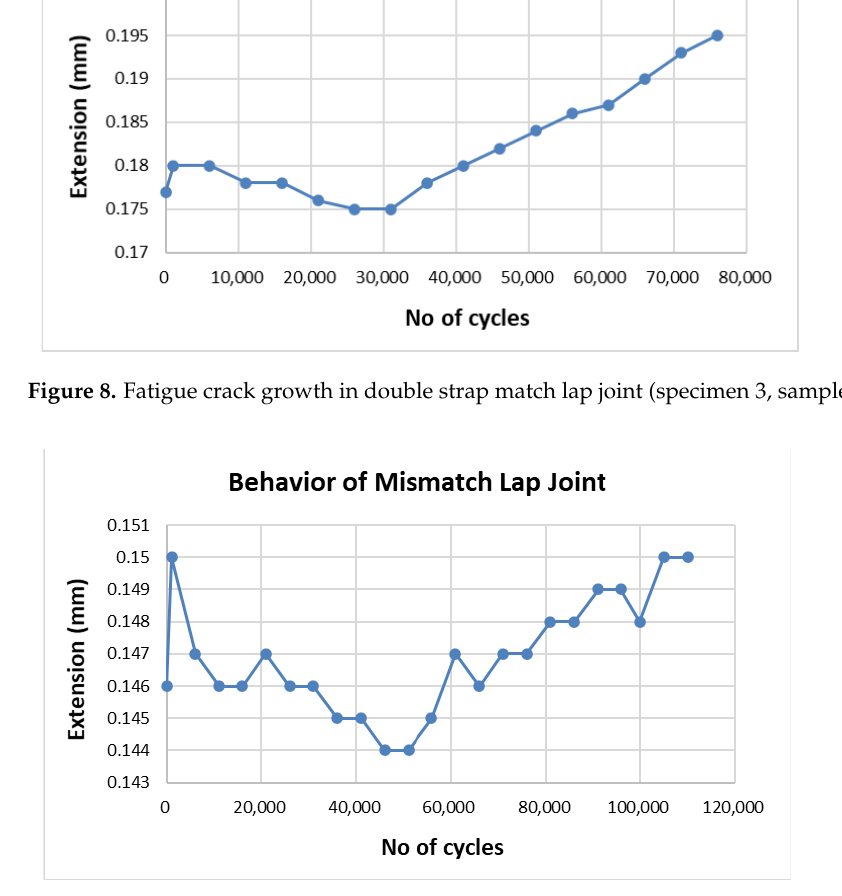
Figure 9. Fatigue crack growth in double strap mismatch lap joint (specimen 4, sample 1).